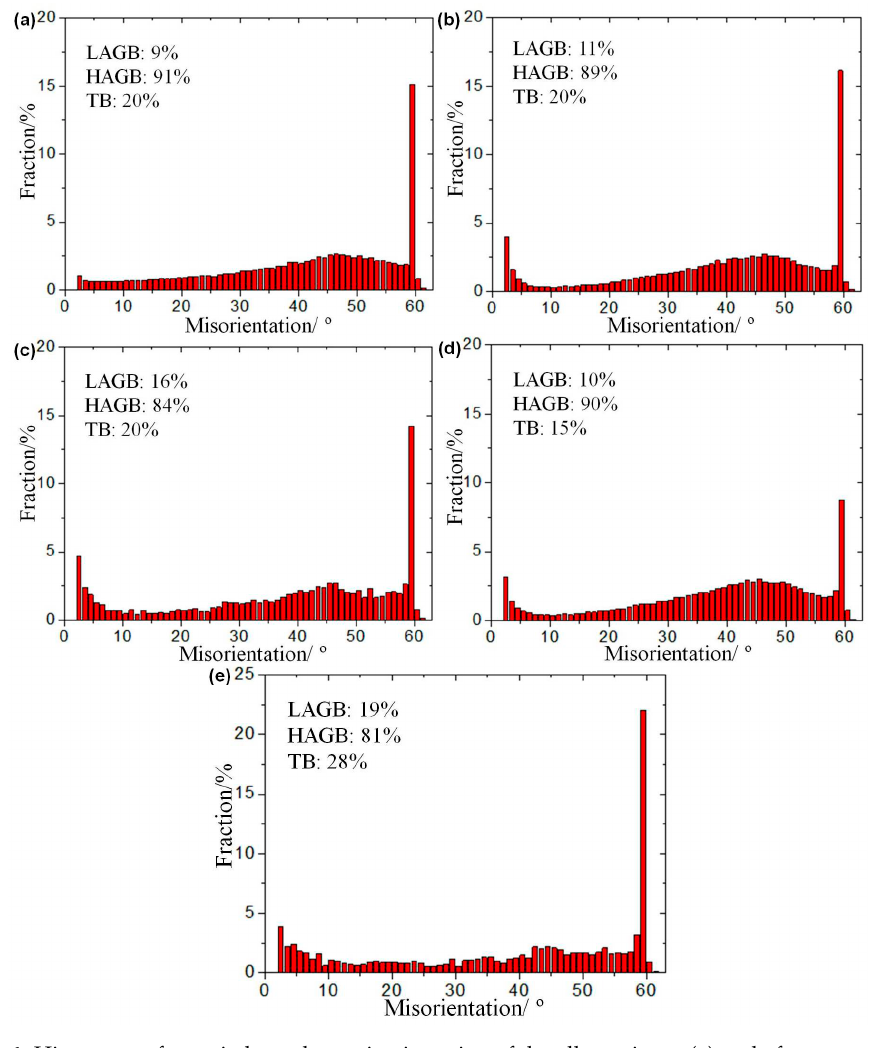
Figure 4. Histogram of γ grain boundary misorientation of the alloy prior to ( a ) and after compression deformation under 1000 °C with the strain rate of 10 − 2 s − 1 ( b ) and 5 × 10 − 4 s − 1 ( c ) and 10 − 4 s − 1 ( d ) and under 1050 °C with the strain rate of 10 − 4 s − 1 ( e ).